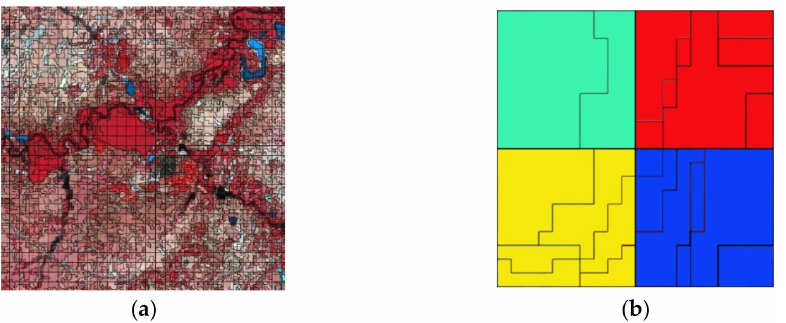
Figure 3. Image segmentation. The base image is an HSR remote sensing dataset (Landsat 8 OLI data): ( a ) is the segmentation of the Landsat image overlapped with a MODIS cell layer, and ( b ) is an example of segmentation results with a zoomed-in view constrained by four MODIS pixels. The four pixels from the HTR data appear as square black lines in green, red, yellow, and blue colors, respectively. The segmentation results also appear as black